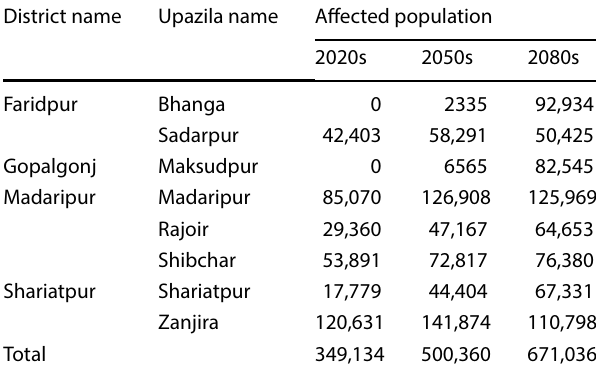
Table 5 Upazila-wise affected population for RCP 8.5-SSP5